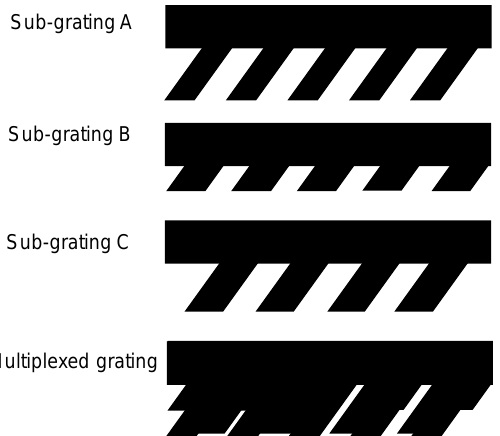
Figure 5. Decomposition of multiplexed grating into three sub-gratings. Say the periods of sub-gratings are p A , p B , and p C , respectively, then the collective period P m of the multiplexed grating shall be the least common multiple of the above three.